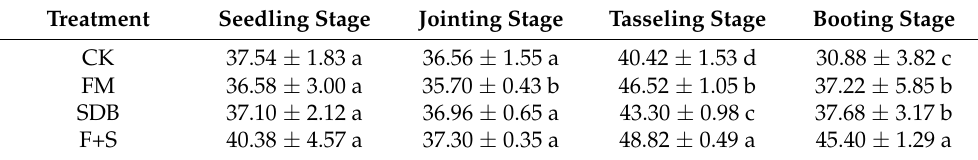
Table 6. The SPAD value under different treatments.